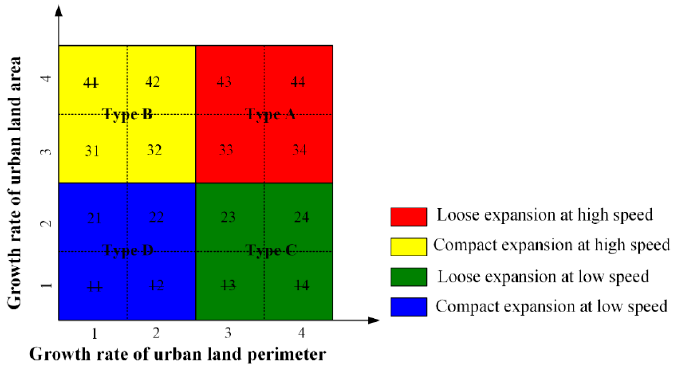
Figure 3. Measurement for characterizing urban expansion types; crossed out numbers do not exist among China’s six megacities in this